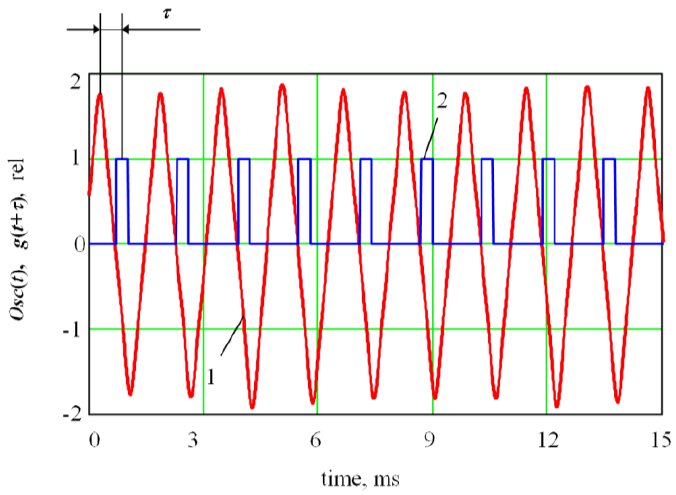
Figure 2. Formation of the basis signal g ( t+  ) : 1 a s a waveform of the deflection coil current Osc ( t ) ; 2 is a formed basis signal g ( t+ 